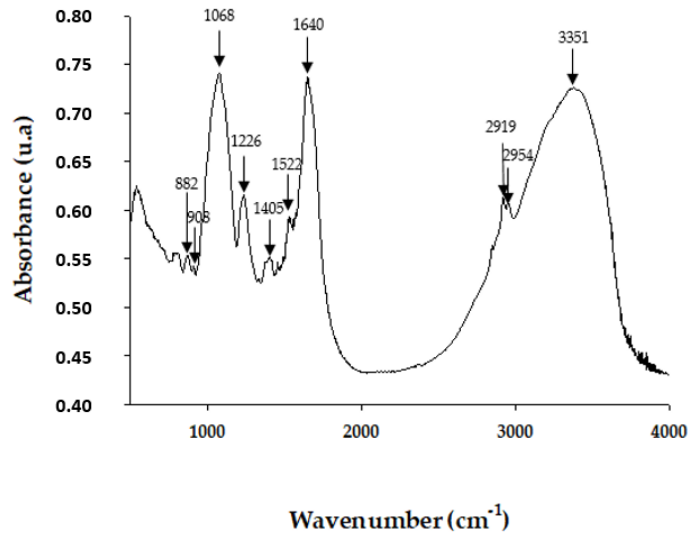
Figure 1. FT-IR spectra of the EgPs.